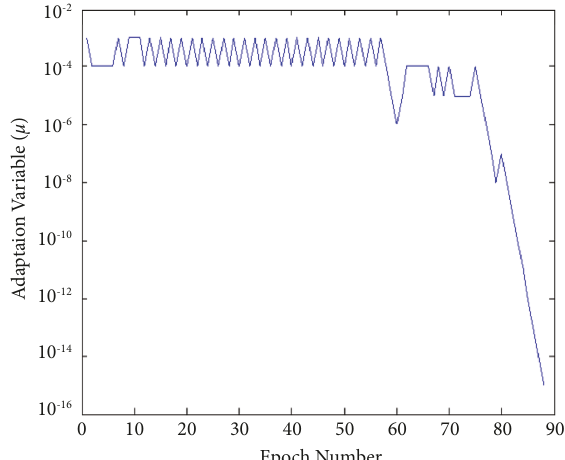
Figure 5: Variation of µ during the 3-set neural network training